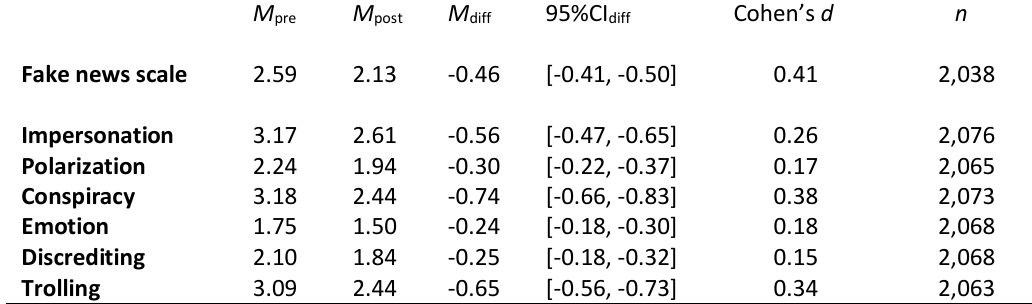
Table 4. Average reliability (pre-post) judgments overall and for each fake news badge by country (Germany).